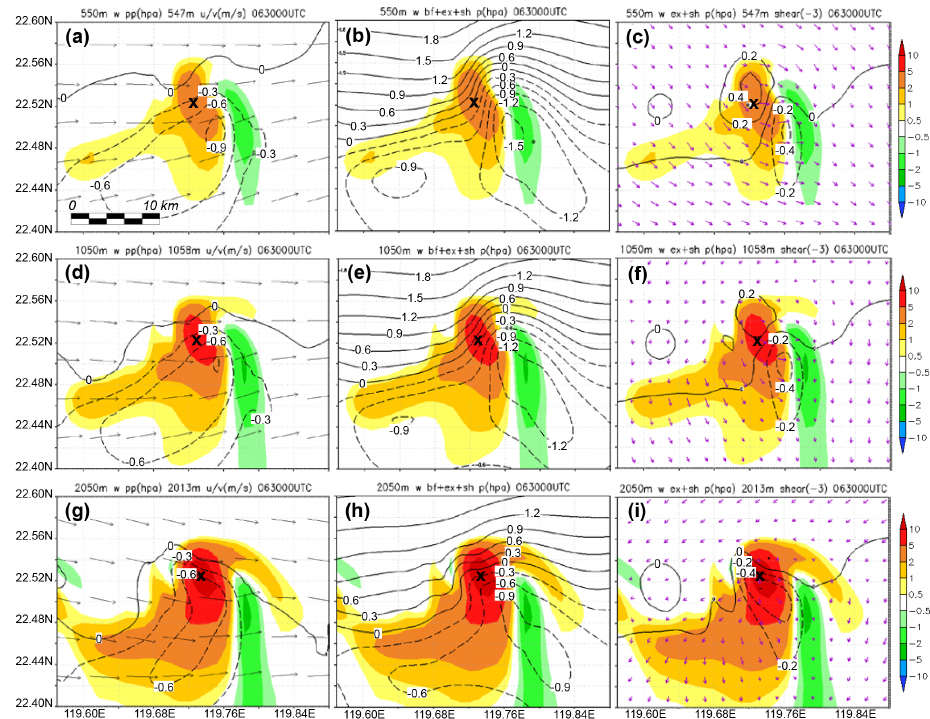
Figure 13. Model-simulated w (ms − 1 , color, scales on the right) and (a) total p (cid:48) (hPa, contours, every 0.3hPa, dashed for negative values) and horizontal winds (ms − 1 , vectors, reference vector at bottom), (b) p (cid:48) (hPa, contours, every 0.2hPa) solved by the relaxation method and vertical wind shear (10 − 3 s − 1 , purple vectors, reference vector at bottom) at 550m at 06:30UTC, 8 August 2009. (d – f) and (g – i) as in (a – c) , except at 1050 and 2050m, respectively. For horizontal wind and vertical wind shear, vectors at the closest model output level (547, 1058, and 2013m, respectively) are plotted, and the “x” marks the updraft center in each